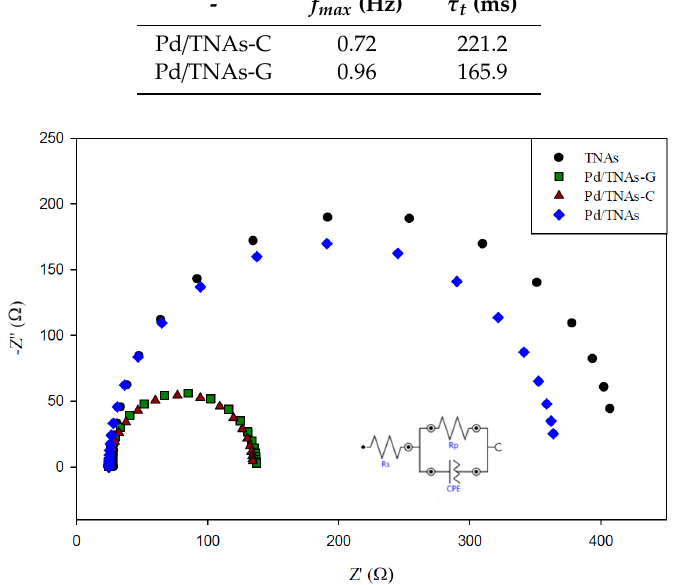
Figure 6. Nyquist graph of TNAs, Pd/TNAs, Pd/TNAs-C, and Pd/TNAs-G under 100 W Hg lamp.